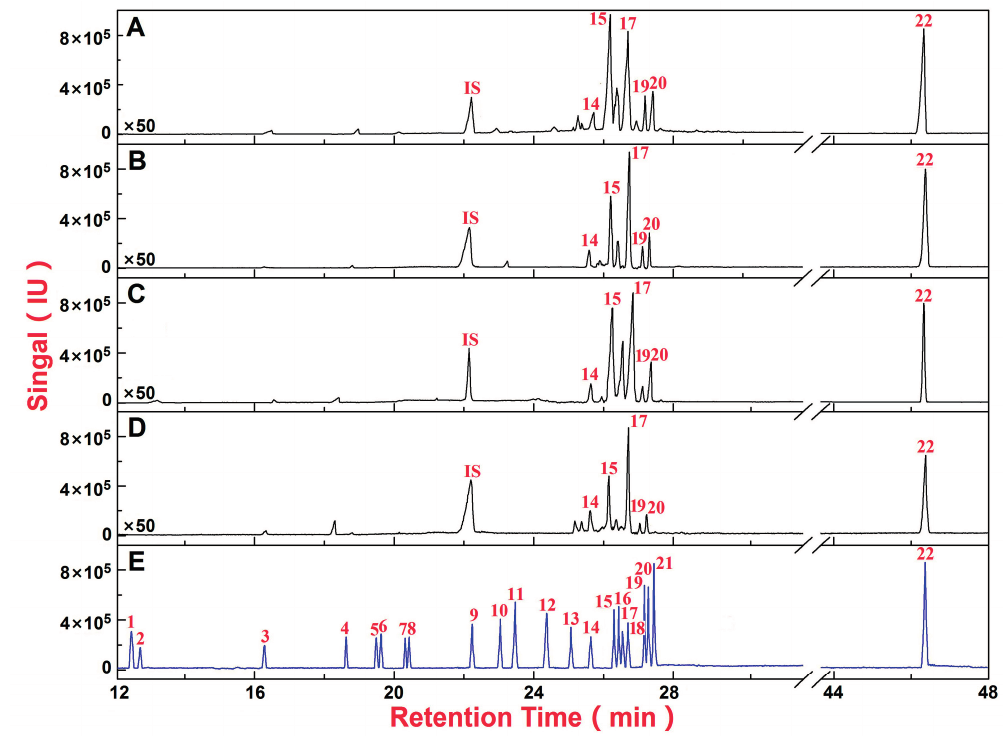
Figure 1. Chromatograms of the total ion current of the acetylated monosaccharide, disaccharide standards and determination of RA samples. Saccharide mappings of the perennial membranaceus var. Mongholicus (Bge.) ( A ); fast-growing membranaceus var. Mongholicus (Bge.) ( B ); perennial membranaceus (Fisch.) Bge. ( C ); fast-growing membranaceus (Fisch.) Bge. ( D ); and chromatogram of the total ion current of the acetylated monosaccharide and disaccharide standards ( E ). Peak identities: (1) meso -erythritol